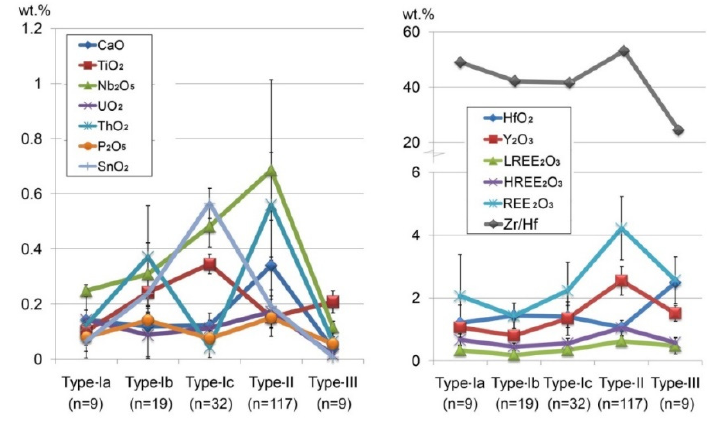
Figure 7. Zircon variation diagram.